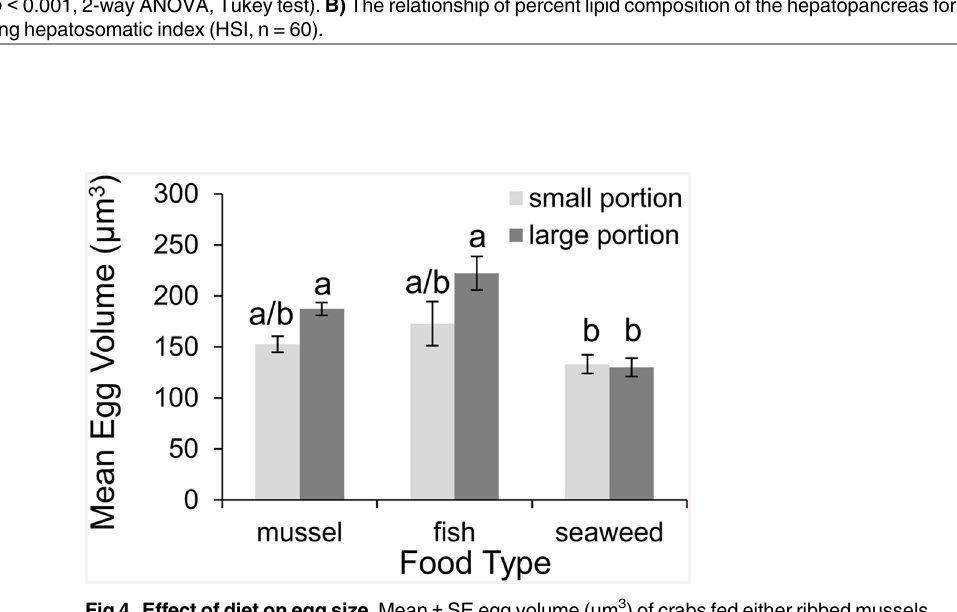
Fig 4. Effect of diet on egg size. Mean ± SE egg volume ( μ m 3 ) of crabs fed either ribbed mussels ( Geukensia demissa ), fish ( Fundulus heteroclitus ), or seaweed ( Ulva lactuca ) at one of two portion sizes (large or small) for ~2.5 months (n =